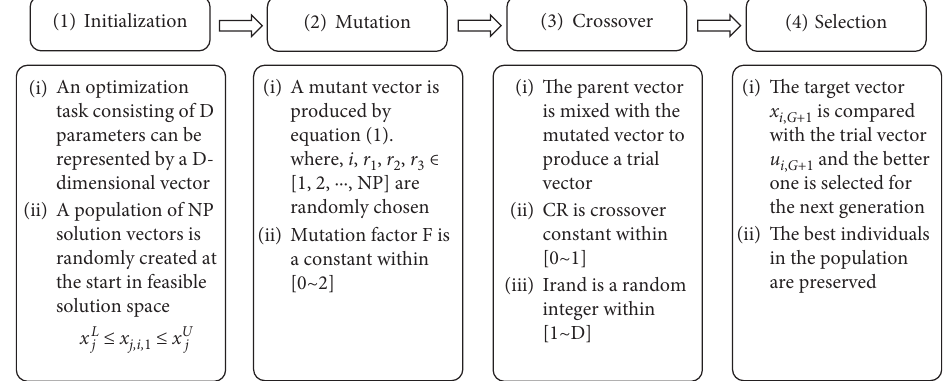
Figure 2: Main stages of DEA (Storn and Price [19]).